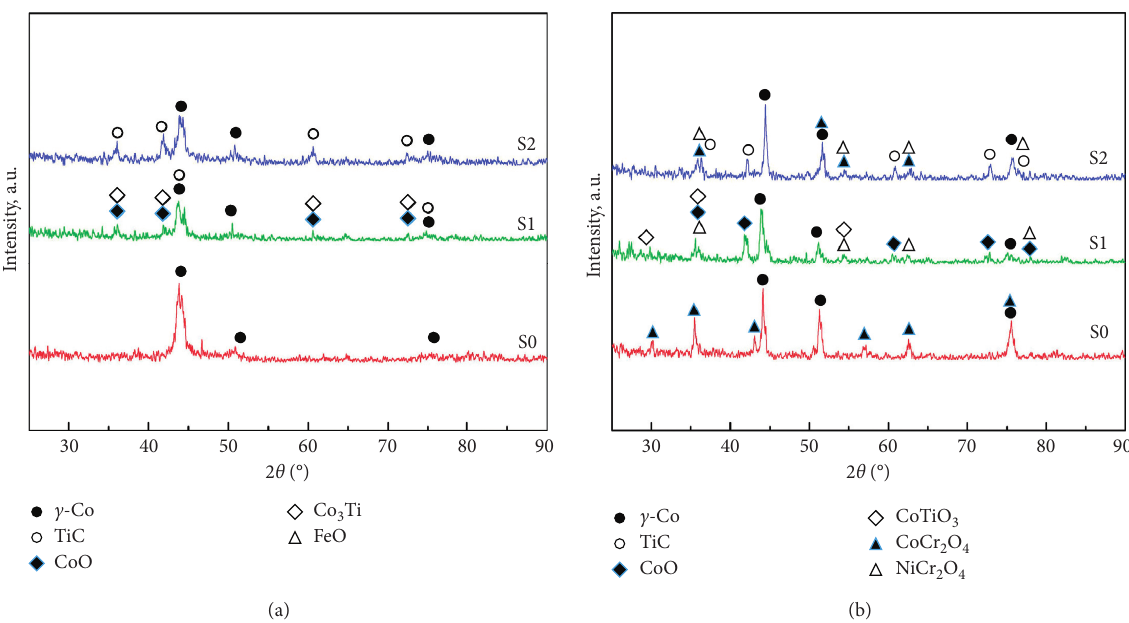
Figure 12: XRD patterns of S0, S1, and S2 coatings at (a) room temperature and (b) 700 °